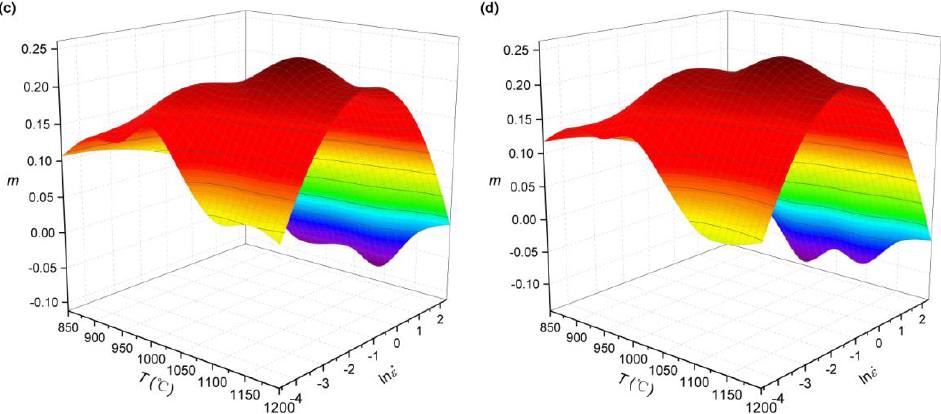
Figure 3. The 3D surfaces of m -value versus strain rate and temperature at true strains of ( a ) 0.2; ( b ) 0.4; ( c ) 0.6; and ( d ) 0.7.